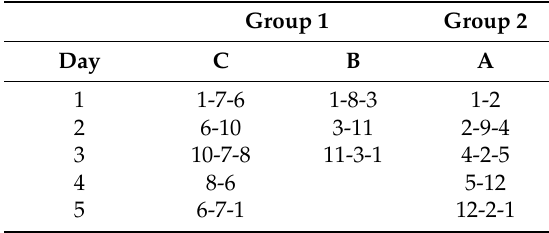
Table 4. The new routing for each group of sellers.